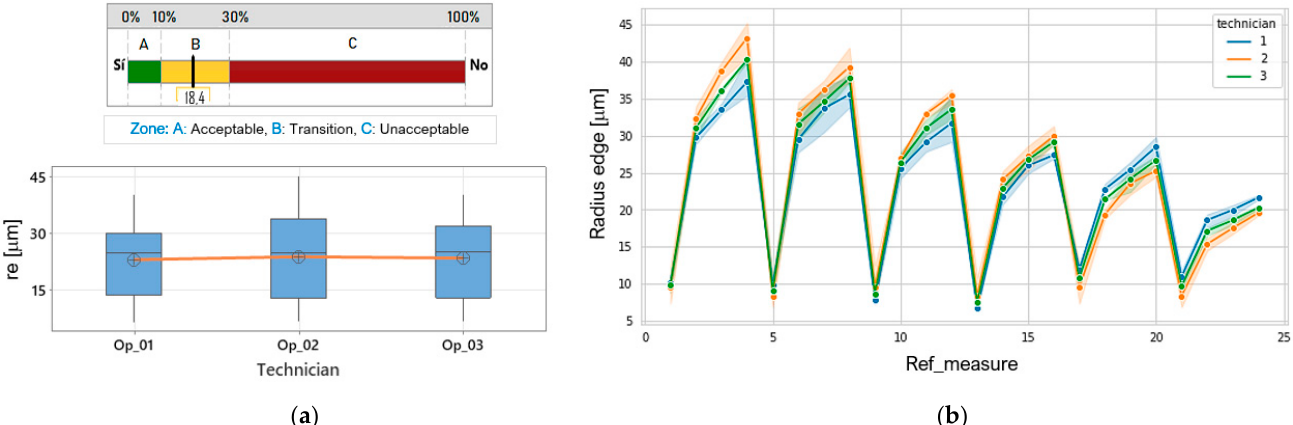
Figure 13. Measurement system capacity, ( a ) determination zones, general rule, ( b ) variability of measurement by technician.